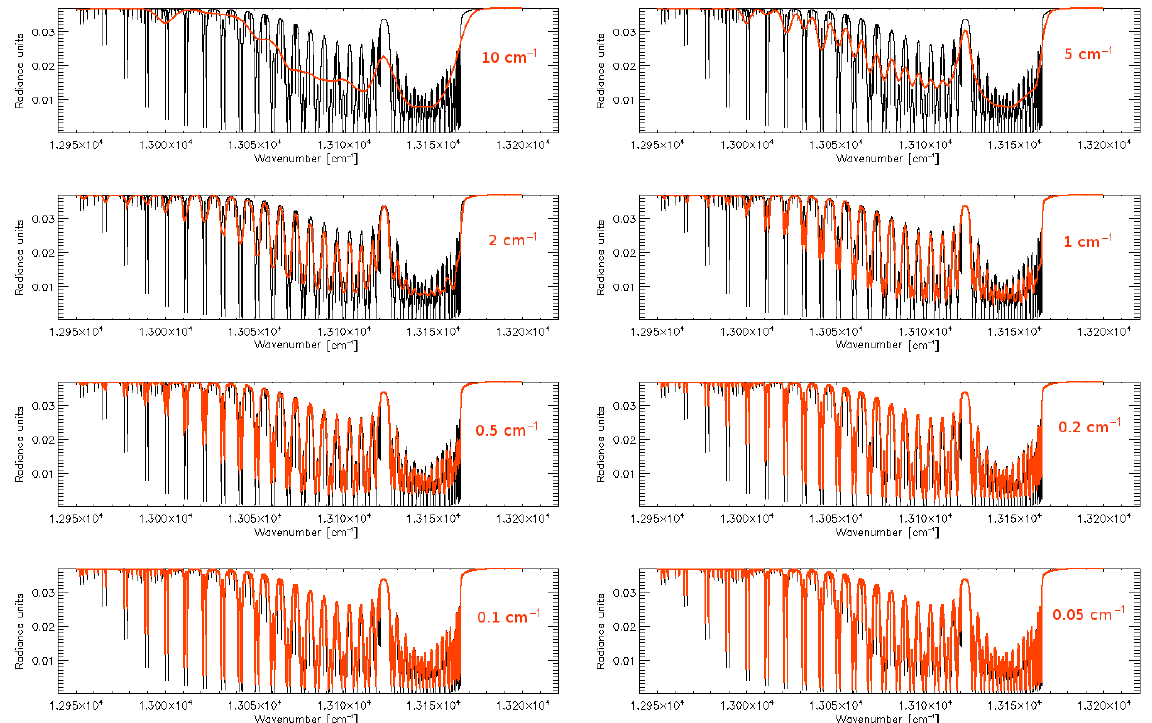
Figure 2. Example of O 2 A-band high resolution spectrum (cid:49)ν 0 = 0.002cm − 1 (black line) convolved with eight different instrument function FWHM (red